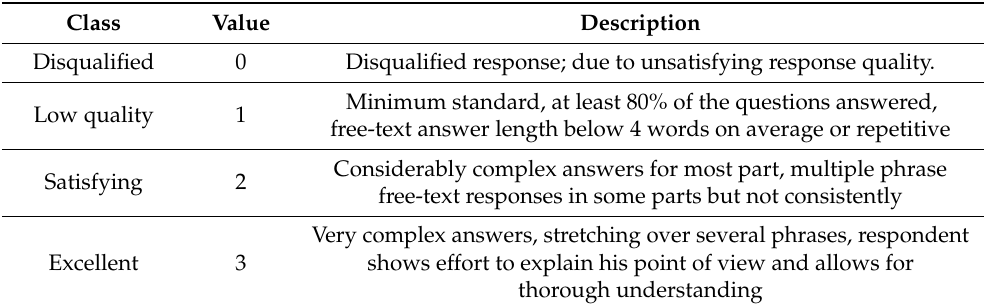
Table 2. Response quality classification system.